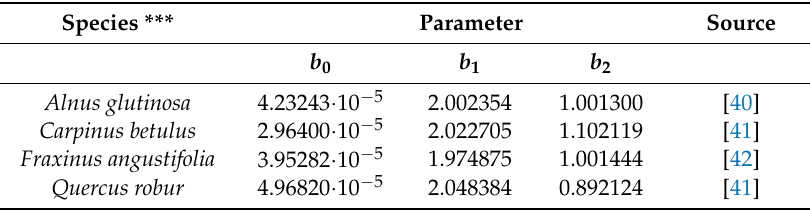
Table A3. Parameters of Schumacher and Hall function * ( V = b 0 × DBH b 1 × h b 2 ) for the wood volume (including bark) of tree stem and branches **.